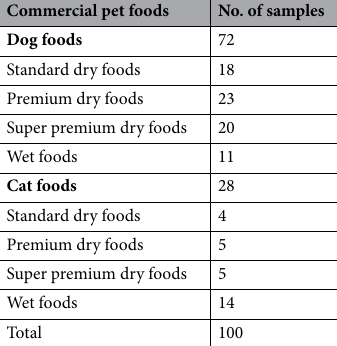
Table 1. Number of samples of each type of commercial pet food analyzed.